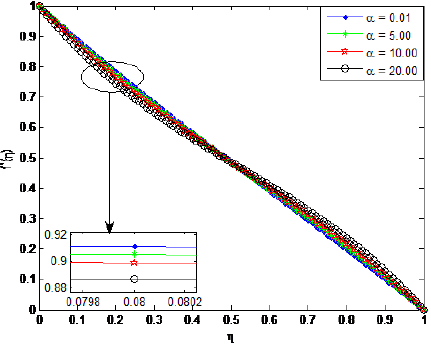
Figure 7. Influence of α on dimensionless velocity profile